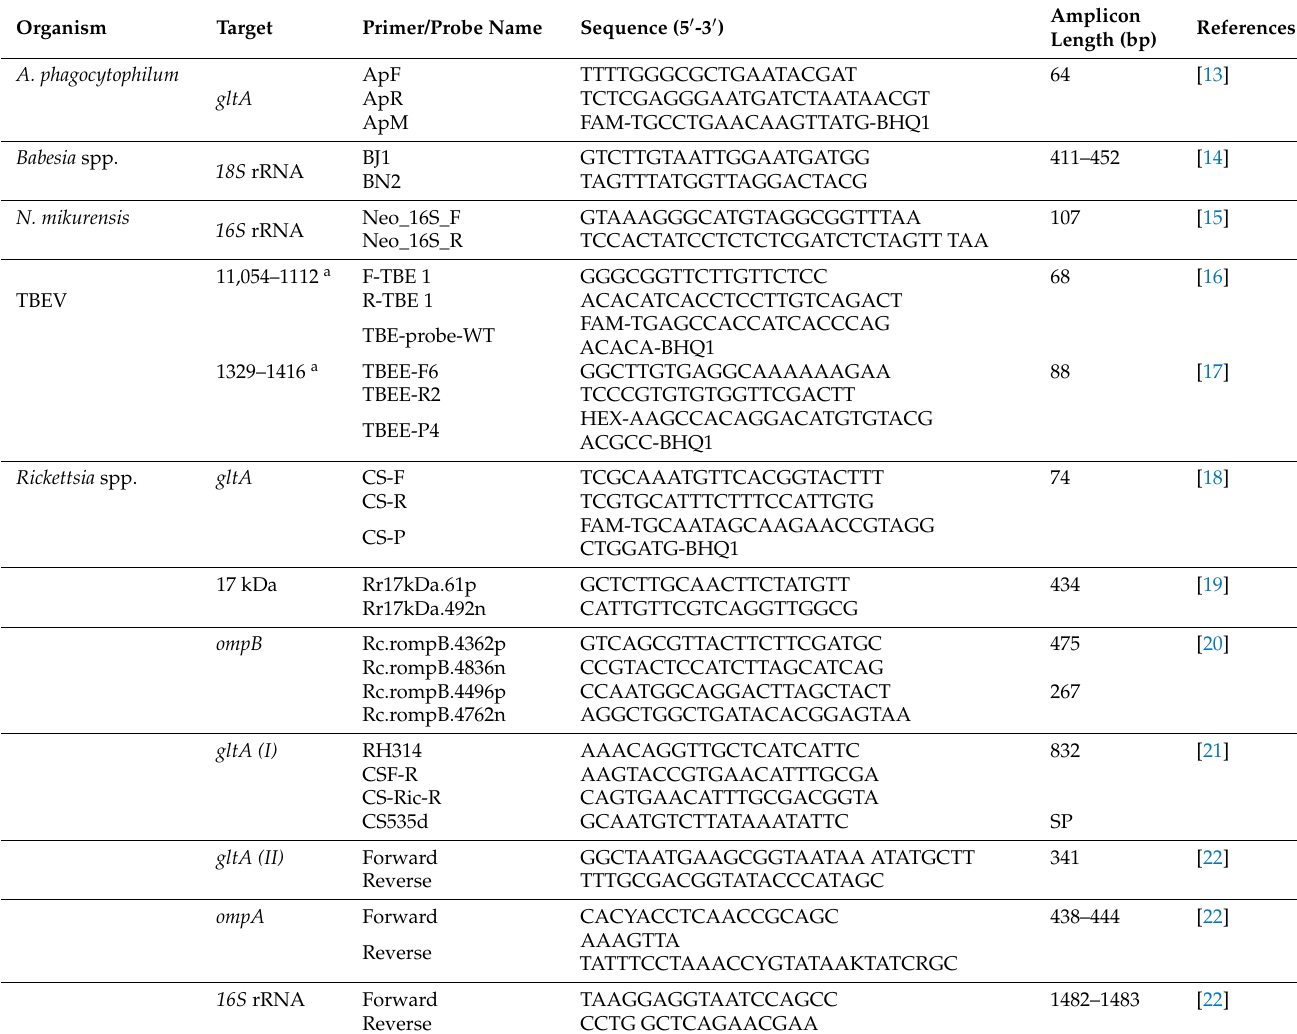
Table 2. Primers and probes used for molecular analysis of tick-borne